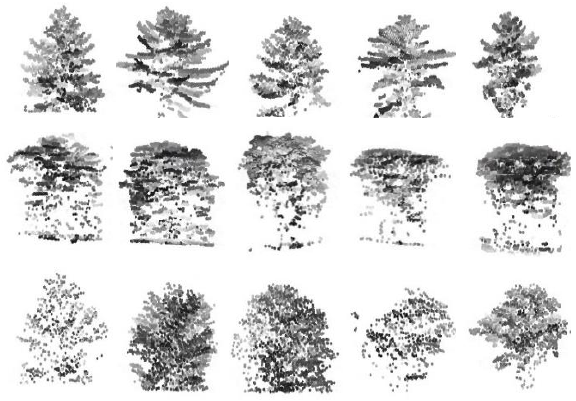
for all 160 trees.